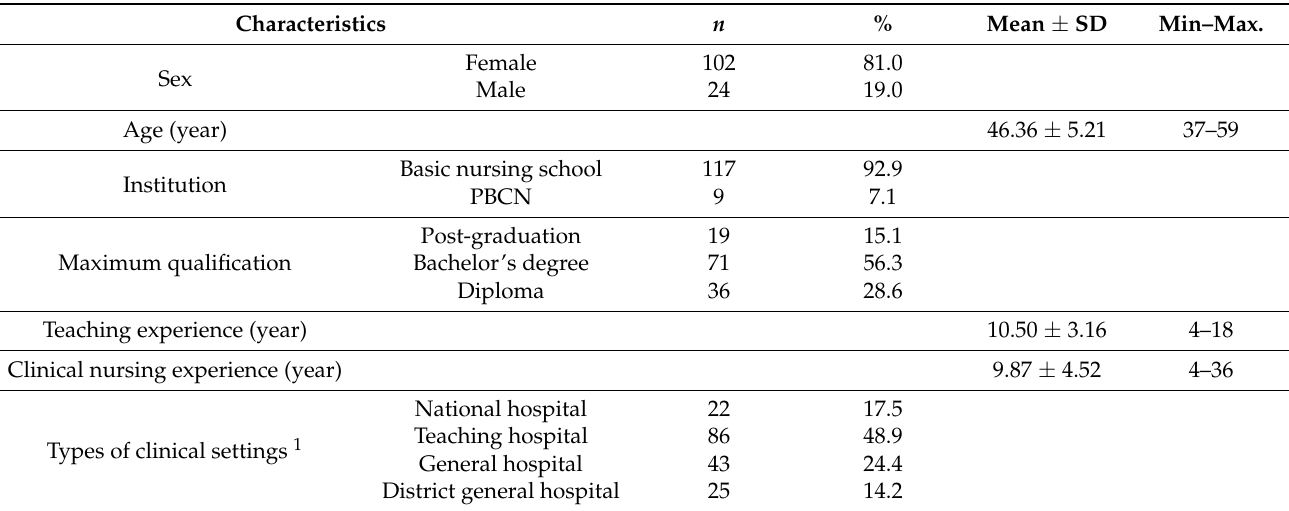
Table 2. General characteristics of participants ( n =